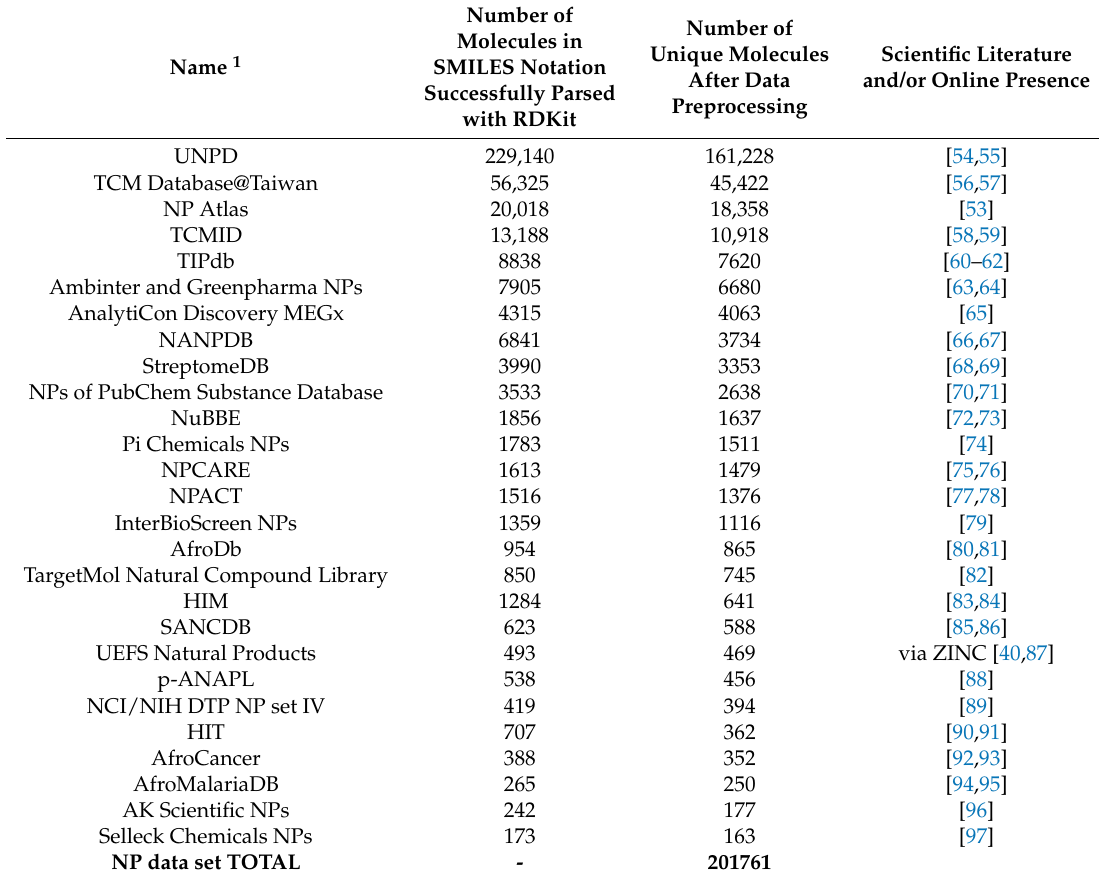
Table 1. Size of the individual data sets prior to and after data